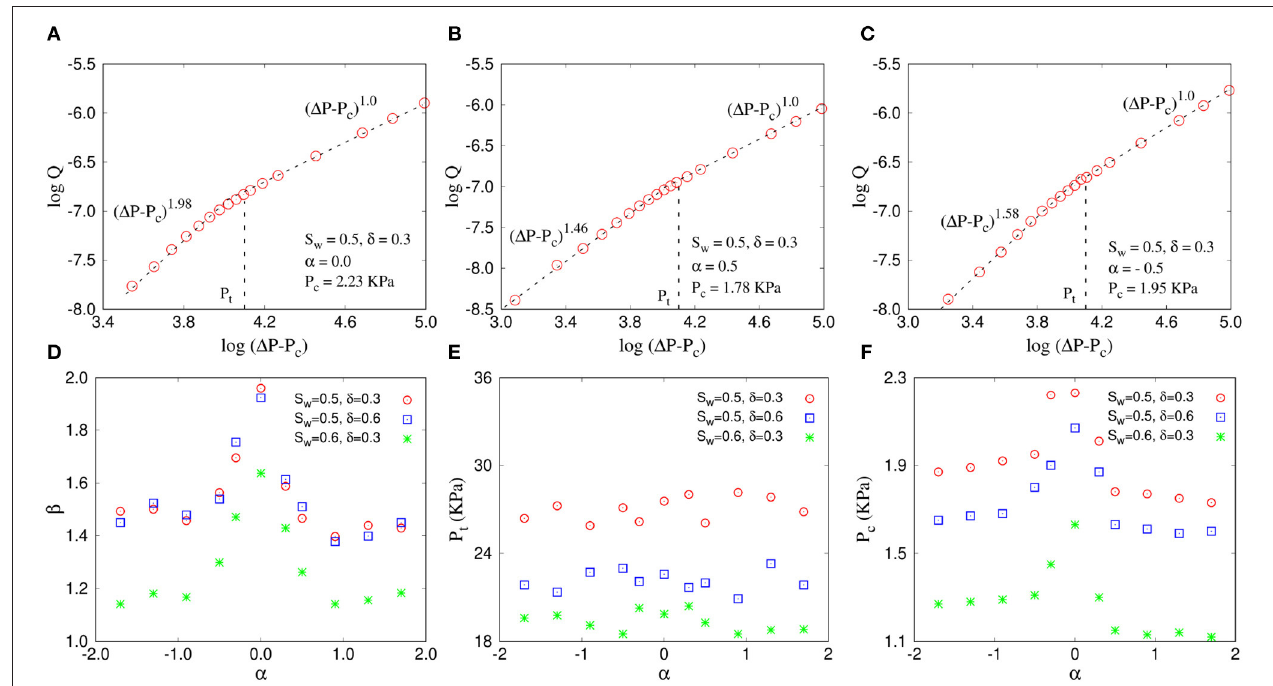
P c (Pa) for a network of 64 FIGURE 4 | Variation of Q (m 3 / s) as a function of 1 P 64 links and for α 0, 0.5, and 0.5 are shown in (A–C) , respectively. The − × = + − wetting saturation S w 0.5 and the distribution width δ 0.3 here. The variations of the slopes β in the non-linear regime, the crossover pressure drop P t (KPa) and = = the threshold pressure P c (KPa) as a function of S w are shown in (D–F) , respectively where β has a maximum at α 0 whereas P t does not show any specific = dependence on α . P c has a maximum around α 0 and decreases on either =